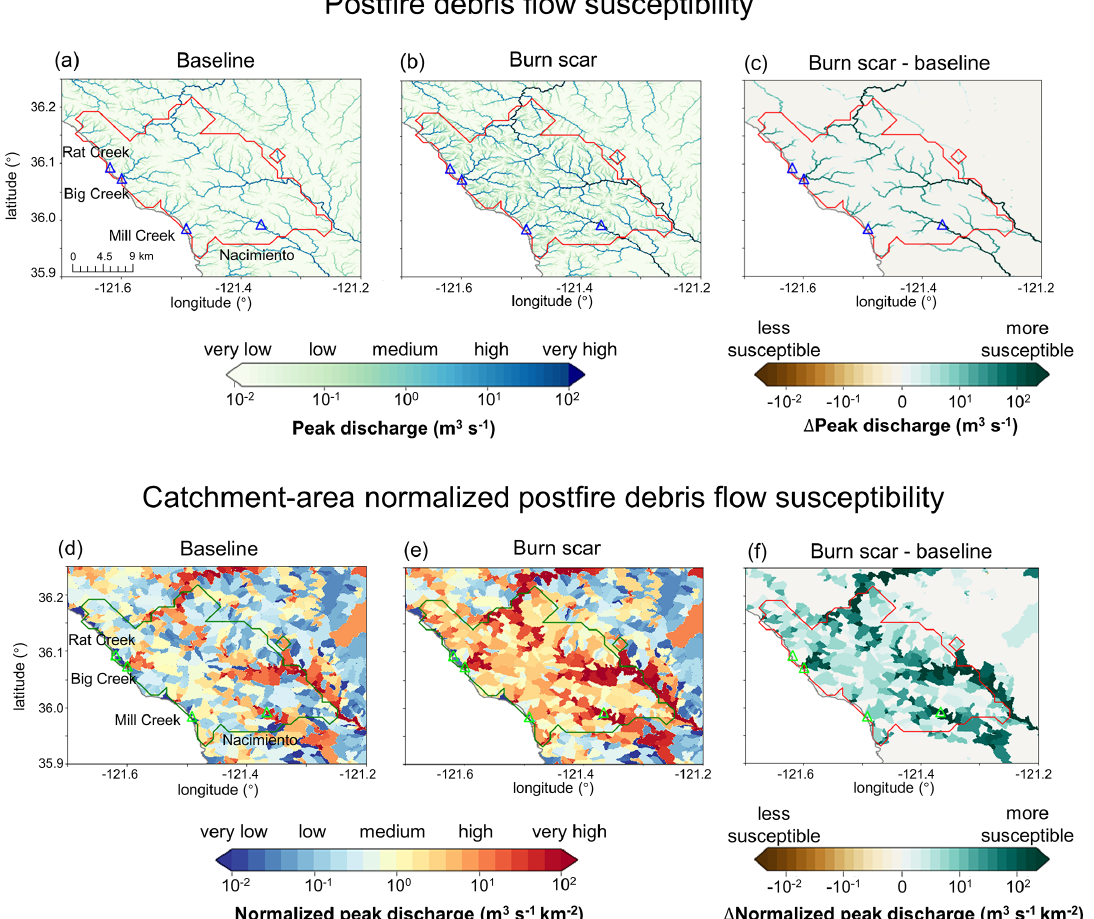
Figure 9. Peak-discharge-based postfire debris flow susceptibility. Peak discharge at individual stream level for the (a) baseline and (b) burn scar simulations and (c) the difference between burn scar and baseline simulations from 27 January 00:00 to 28 January 12:00 (m 3 s − 1 ). (d) – (f) Normalized peak discharge by catchment area at catchment level (m 3 s − 1 km − 2 ; shading). For each catchment, the peak discharge is the maximum discharge rate at the catchment outlet from 27 January 00:00 to 28 January 12:00 divided by catchment area. Triangles stand for debris flow deposition locations and are annotated in (a) and (d) . We conduct similar analyses using accumulated discharge volume in Fig. B6 in Appendix B.